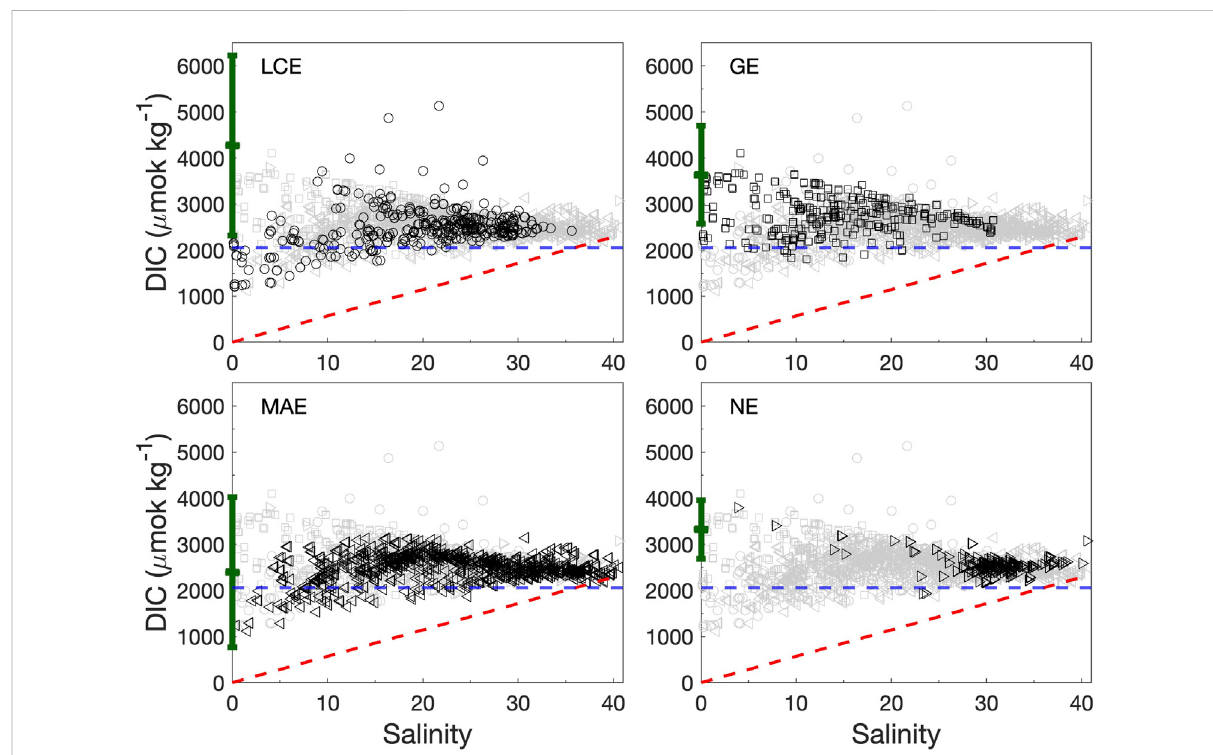
FIGURE 5 DIC vs. salinity in the four studied estuaries during 2014 – 2018. Data from each panel are shown in black symbols against the entire dataset (gray). The green error bar in each panel represents the river endmember value (±1 standard deviation) for the corresponding estuary (Yao et al., 2022). The horizontal dashed line (blue) represents the open ocean TA value (2060 μ mol kg − 1 at salinity 36) (Hu et al., 2018). The red dashed line represents the precipitation-evaporation line based on the ocean endmember